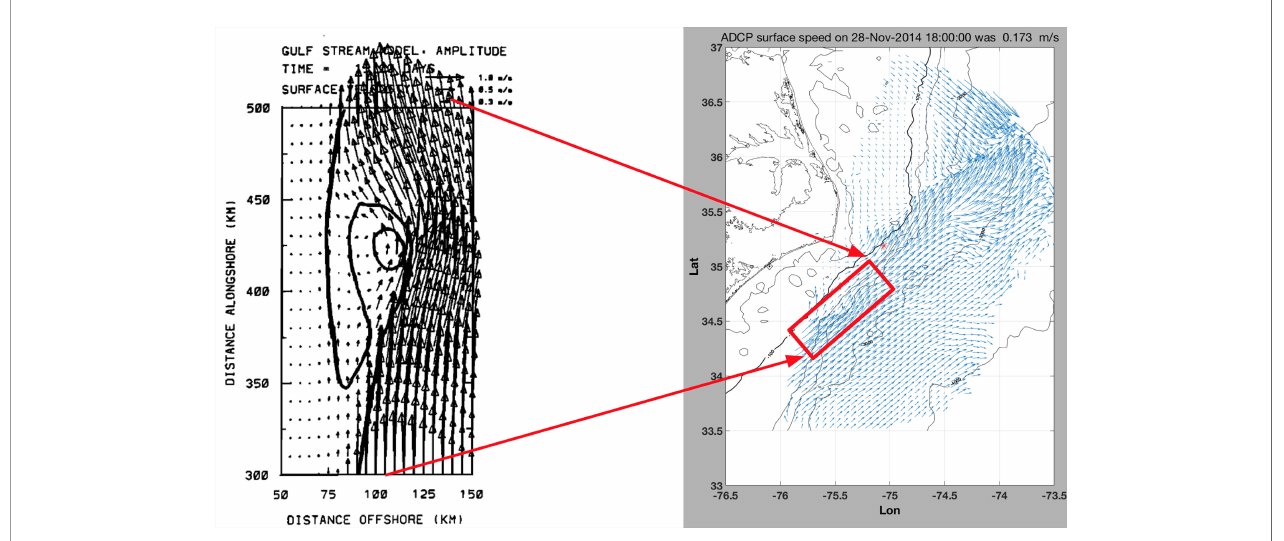
FIGURE 9 | Similar surface current circulation around a meander trough between modeled (left) and HFR observed currents (right). (Left is from Miller and Lee,